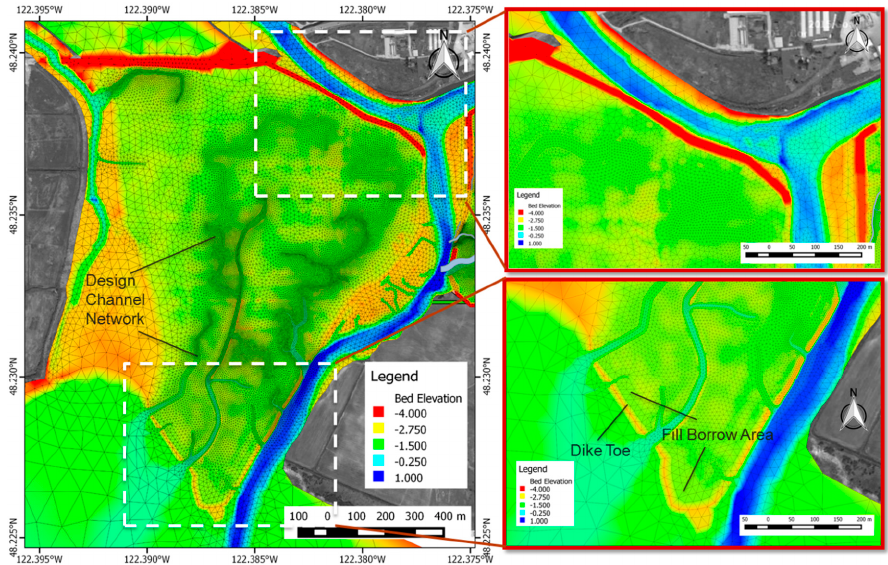
Figure 5. Preferred alternative grid for the Leque Island site.